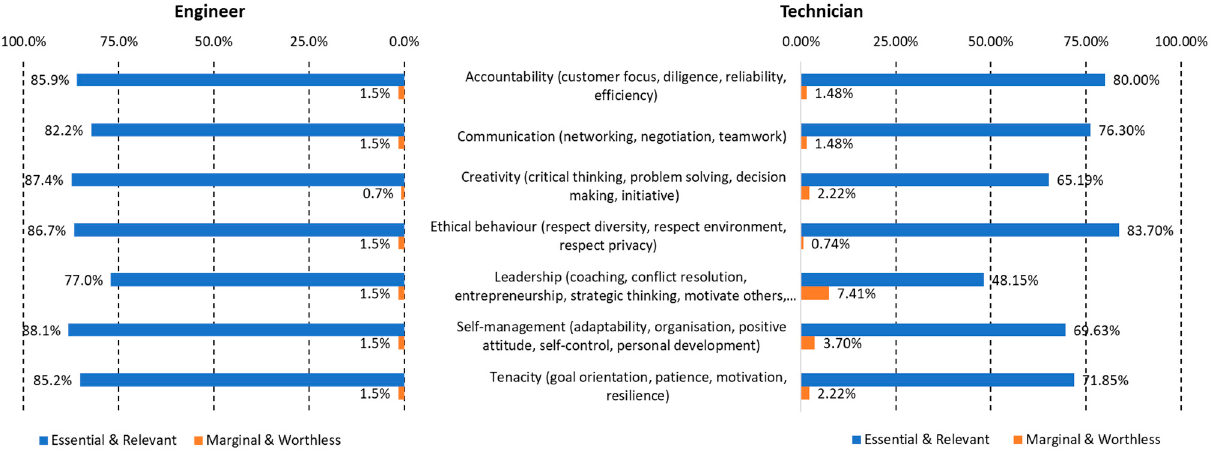
Figure 5. Summary of responses to the agreement on soft skill clusters.